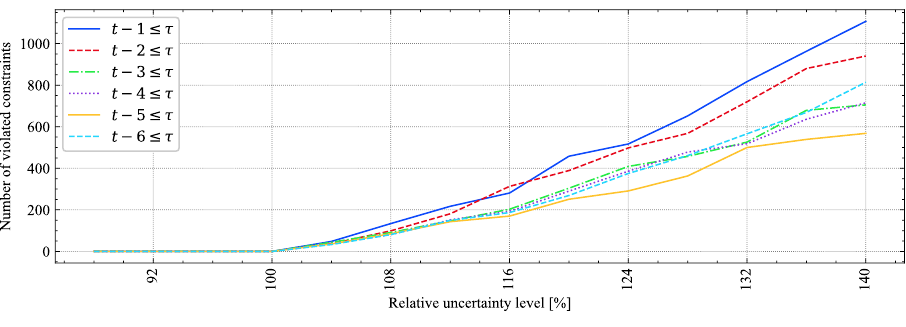
Figure 7. Number of violated constraints vs. materialization of forecast errors, 24-bus system.